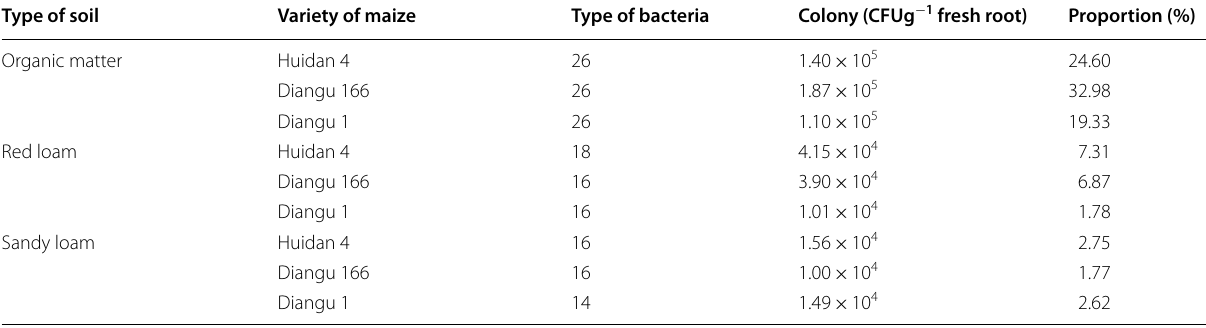
Table 1 The number of culturable endophytes from different varieties of maize seedling roots potted in the different soils Type of soil Variety of maize Type of bacteria Colony (CFUg − 1 fresh root) Organic matter